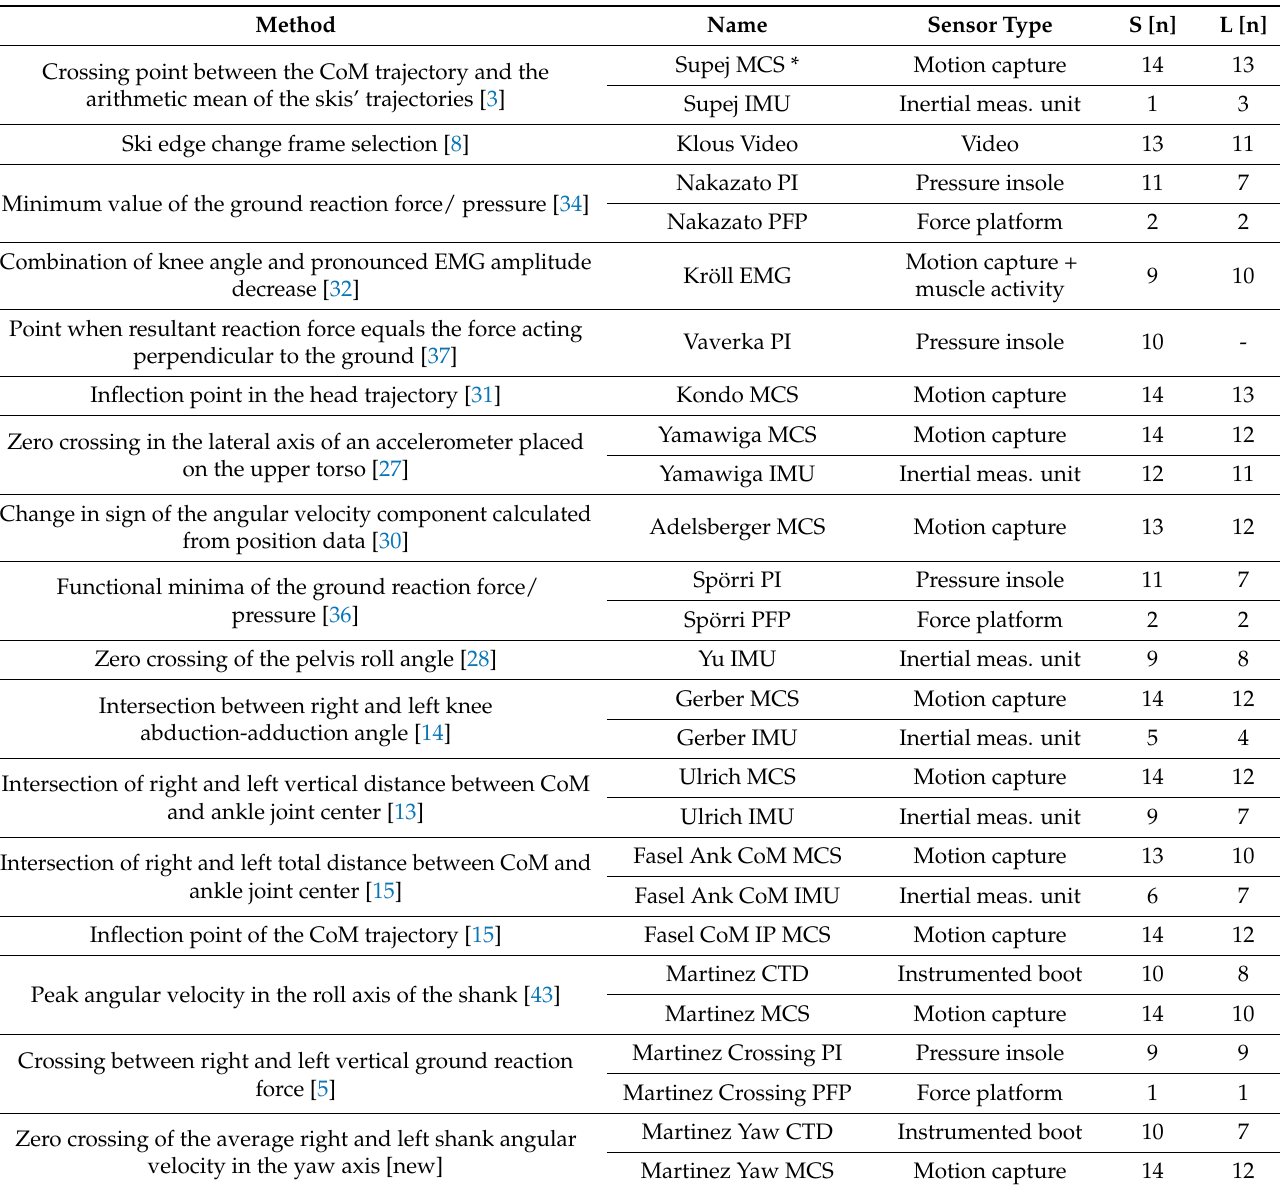
Table 1. Turn switch detection methodologies assessed. A brief explanation of the concept in the “Method” column. The abbreviation used to refer to each method in this manuscript is in the “Name” column. The number of participants included in each method and sensor for short and long turns is under “S [n]” and “L [n]”